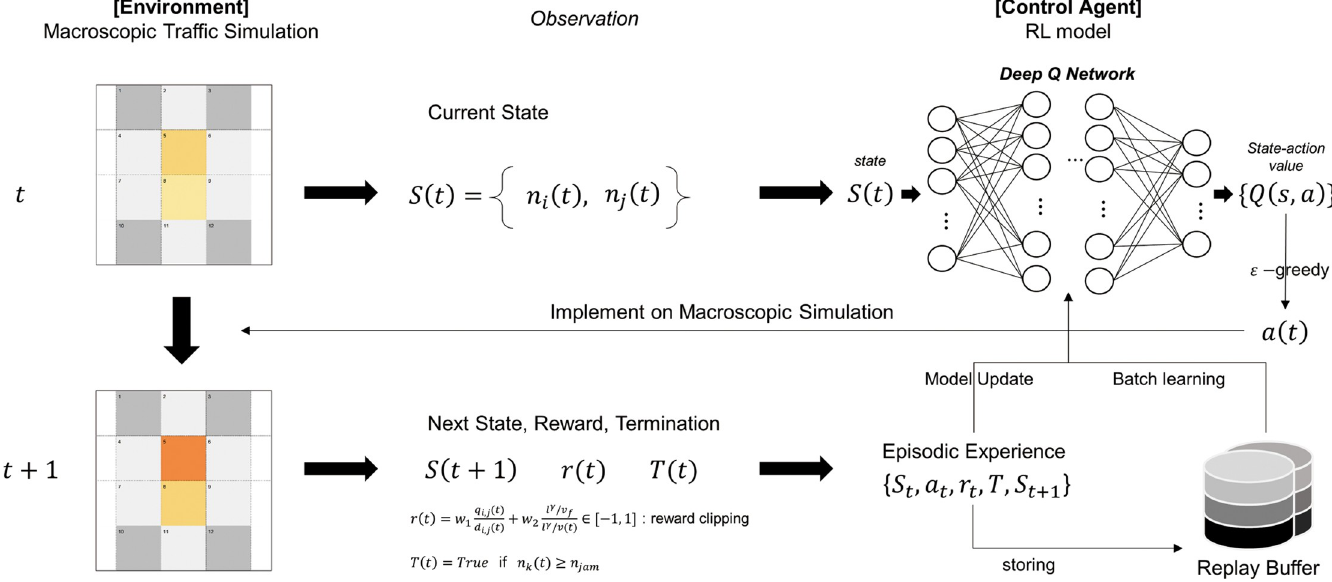
Fig 1. Training framework of the RL-based perimeter control model. (Drawn by